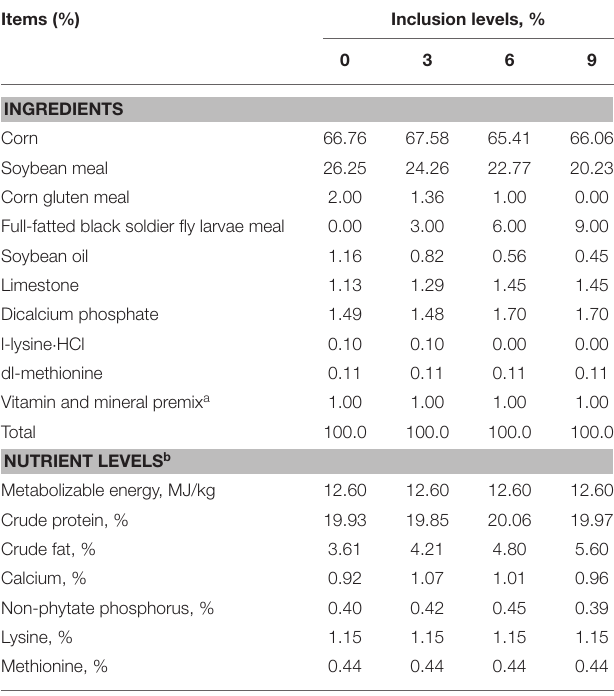
TABLE 1 | Composition and nutrient levels of experimental diets (as fed